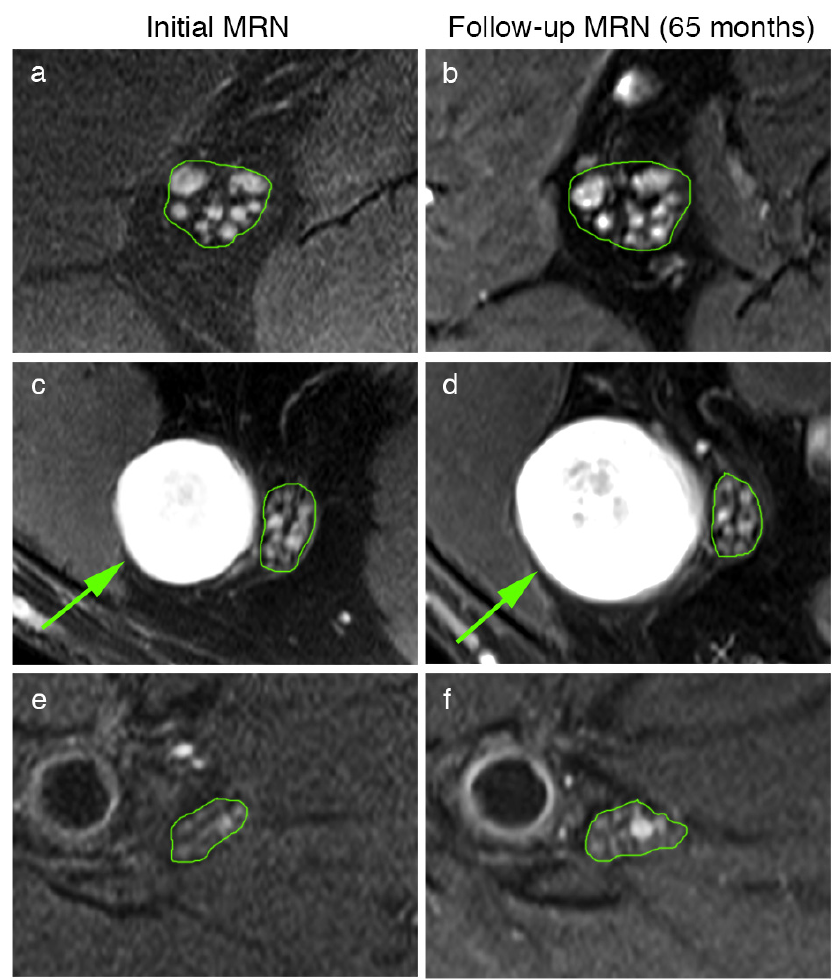
Figure 3. Representative MRN images at different levels of the initial ( a , c , e ) and follow-up